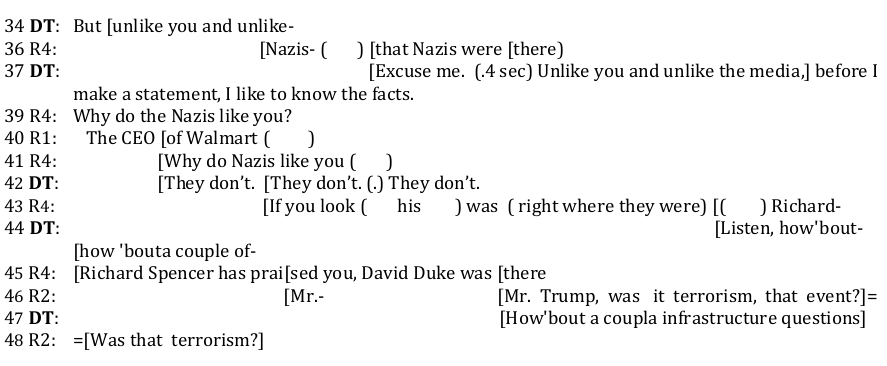
Figure 6. Transcript excerpt 34–48.